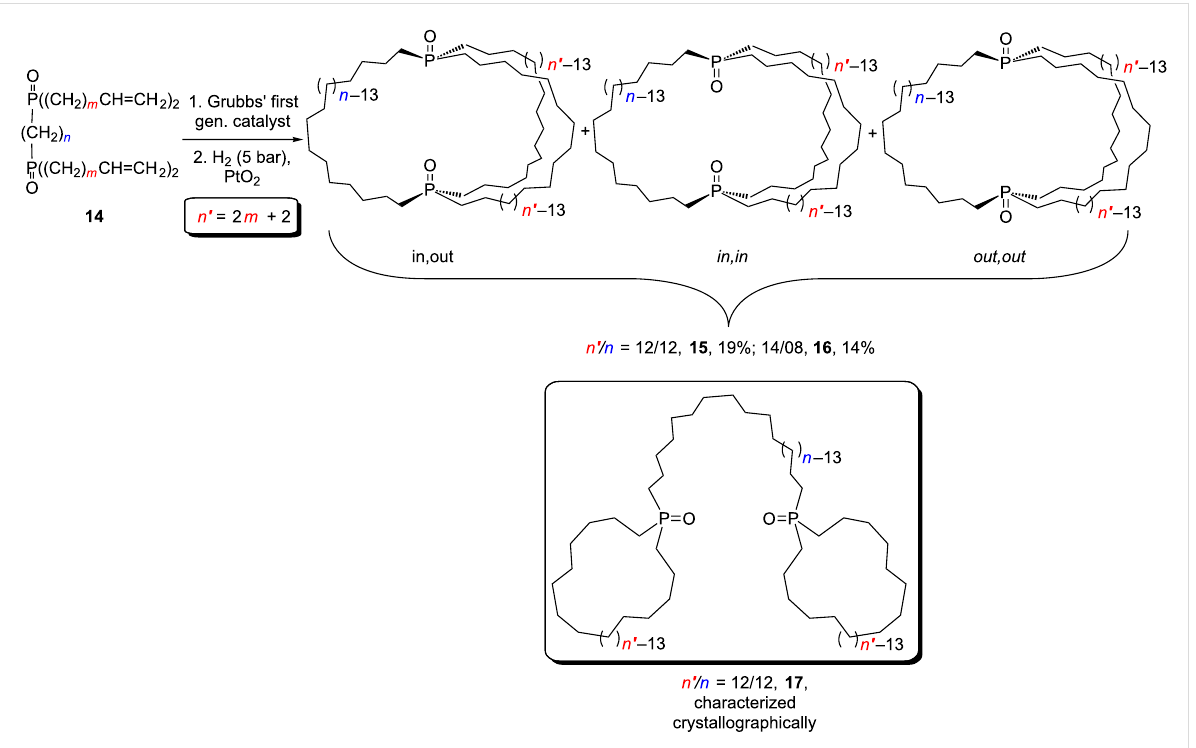
Scheme 8: Another non-metal-templated approach to dibridgehead diphosphorus